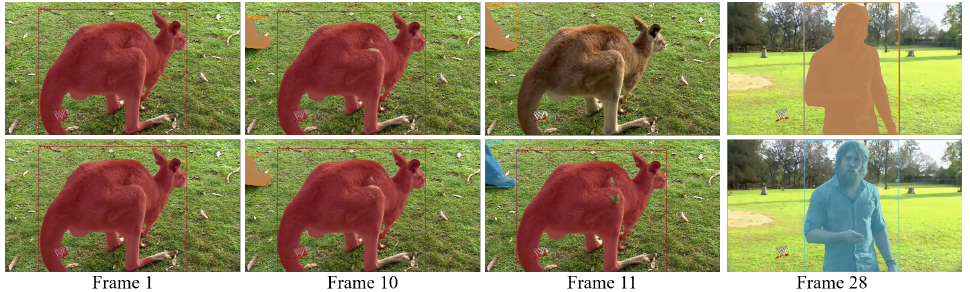
Figure 5. An example of the idle query rollback mechanism. At each frame, the upper/lower image is the result without/with this